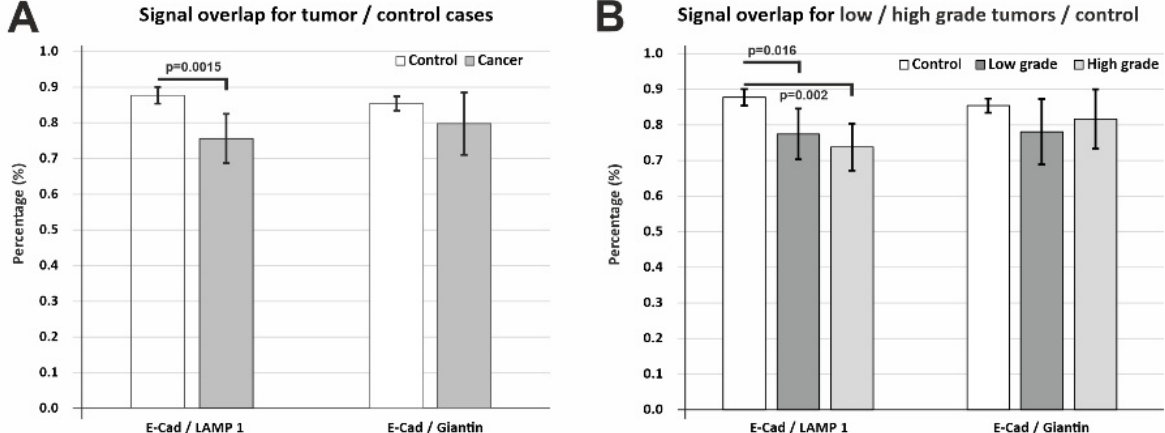
Figure 8. Fluorescence signal overlapping coefficients for LAMP1/E-cadherin and Giantin/E-cadherin. ( A ) Overall analysis of tumor versus control epithelia showed that the colocalization decreased in cancer, but less drastically for colocalization with Giantin. ( B ) Stratification of tumor cases into low-grade/high-grade tumors showed that colocalization with LAMP1 decreases towards less differentiated tumors, while colocalization with Giantin actually increases (although non-significantly) towards high-grade tumors. Significance is shown for Student’s t-test ( A ) or using a one-way ANOVA followed by a post hoc Fisher’s LSD test ( B ). Data are expressed as means ± SD.